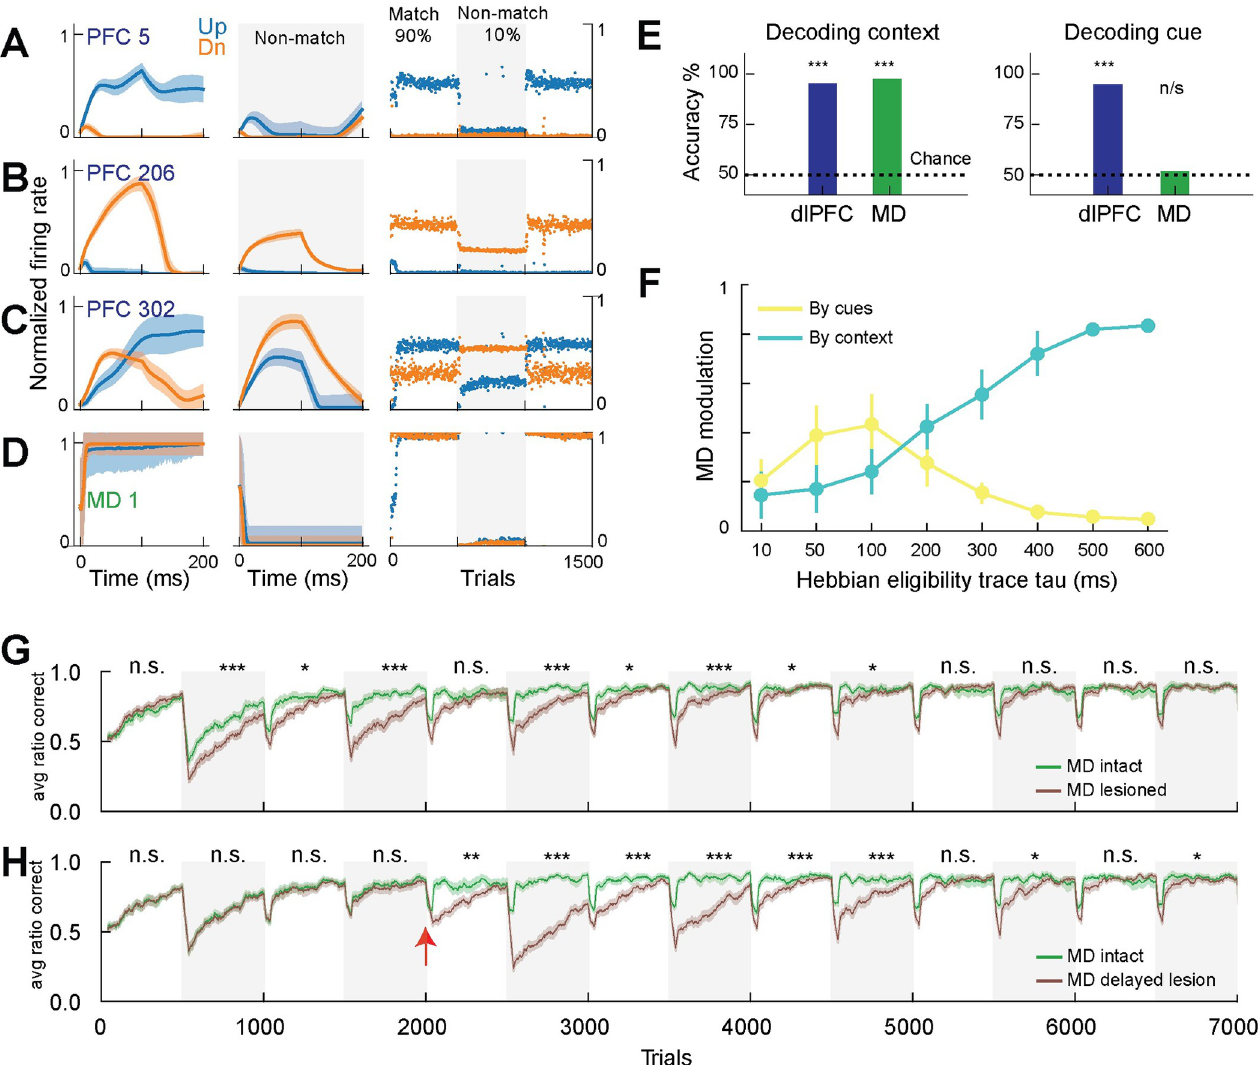
Fig 3. Context encoding in MD enhances prefrontal cognitive flexibility in the neural model. A-C. Example responses from 3 dlPFC neurons to sensory input (‘Up’ or ‘Down’) in trials where match strategy was rewarded (match block, left panels), or non-match strategy was rewarded (non-match block, middle panels), and the trial averaged responses over the first 3 blocks of the experiment (right panels). D. The same panels for one MD neuron showing responses selective to match context. E. Quantification of the coding properties using regression to decode task-relevant variables from population activity of either dlPFC or MD. Context could be decoded from either dlPFC or MD (left), but cue was only decodable from dlPFC activity and not MD (right). F. We tested the modulation of MD activity by rule or by cues by taking the correlation between trial-averaged MD activity and a vector representing either the cues (1 for up trials and -1 for down) or rule (1 for match rule or -1 for non-match). To demonstrate the effect of the dynamic Hebbian eligibility trace we tested MD modulation as we varied the eligibility trace time constant (tau). Lower (higher) tau values biased MD to encode sensory cues (rule). G. Comparing mean ( ± STD) of ratio correct responses for MD intact and MD lesioned models from 20 random instantiations of the models. Experiment had blocks alternating between 90% and 10% match trials as other association levels showed similar patterns. H. Same as in G, but showing the effects of lesioning MD after training with MD intact for a few blocks (lesion marked with red arrow). Statistical testing with t-test over performance means in each block for 20 random runs.